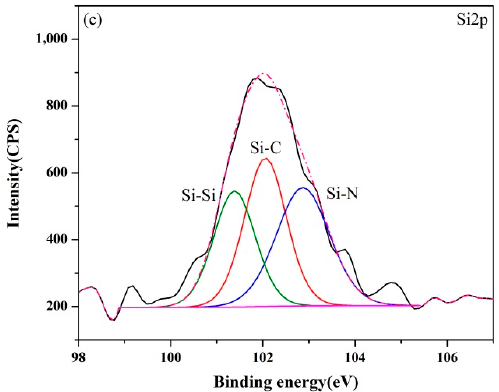
Figure 10. XPS core-level spectra of sample E synthesized at 1550 °C: ( a ) C1s, ( b ) N1s and ( c ) Si2p.